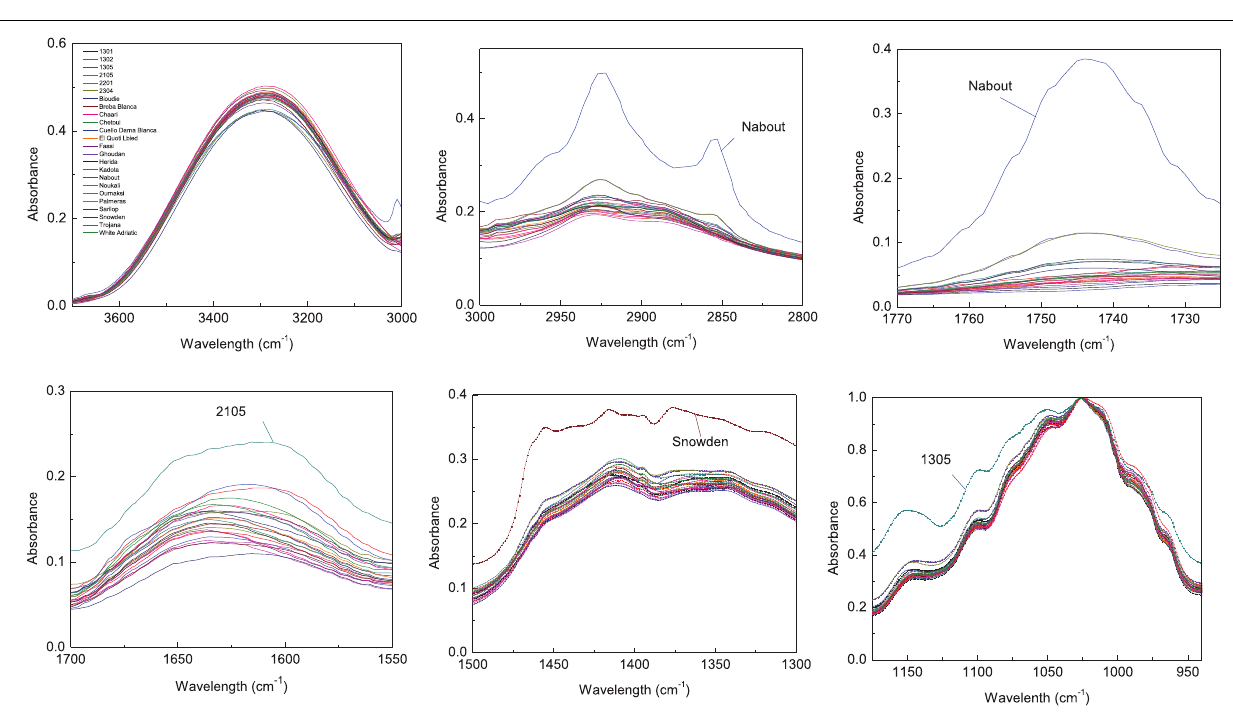
Frontiers in Plant Science |